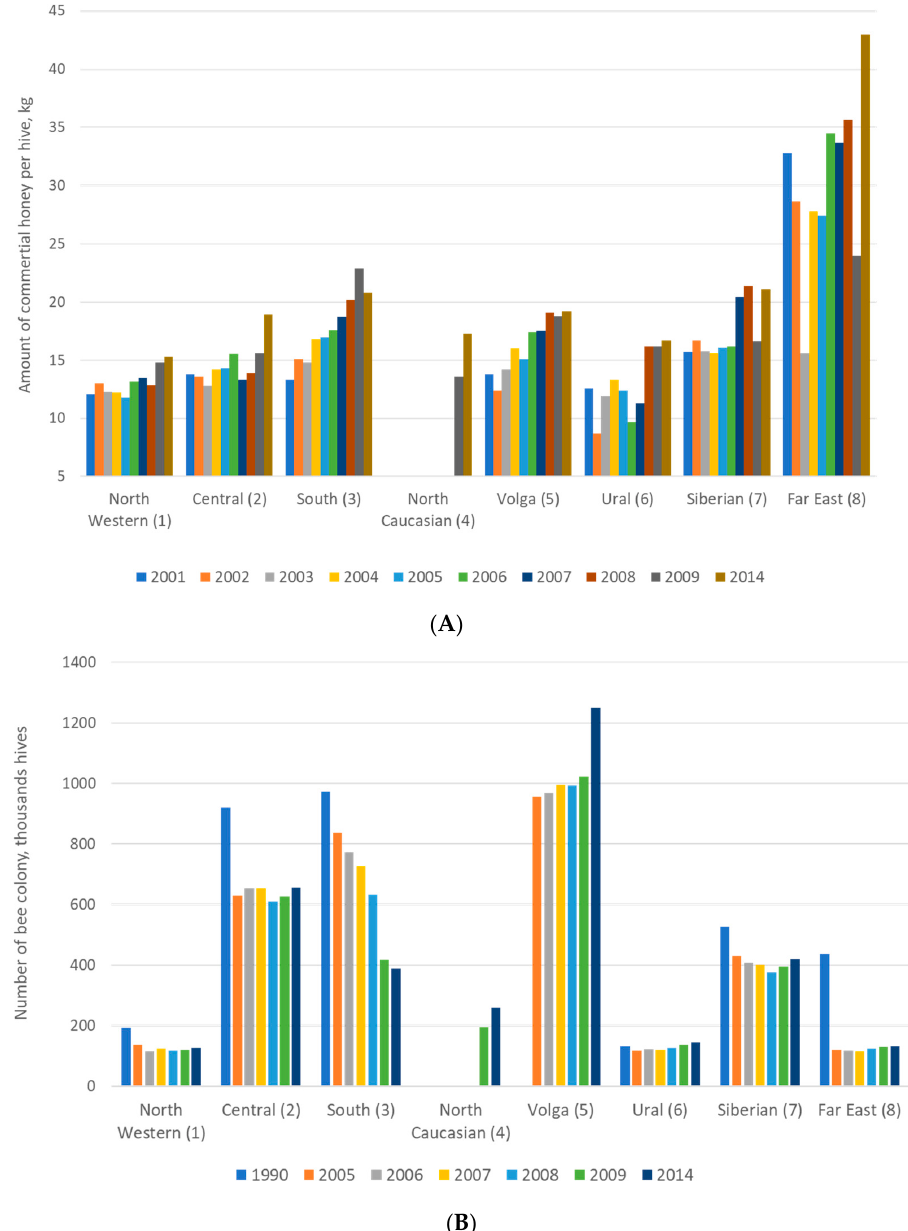
Figure 3. Honey productivity ( A ) and number of bee colonies ( B ) in eight federal districts in the Russian Federation. The morphometric method was developed by a Russian scientist, Alpatov (1929) [97] Morphometry is a quantitative phenotypic method that analyzes the size of morphologi- cal traits at the individual level in honey bees [98]. Ruttner (1988) [99] evaluated bees using thirty-three morphometrics traits, although Russian scientists preferred to measure no more than eight morphometric traits in honey bees: body color, length of the proboscis, width of tergite 3, length of veins “a” and “b” of the right forewing to calculate the cubital index, width and length of the metatarsus to calculate the tarsal index, and the discoidal shift of the right forewing [42,84,100]. The morphometric traits of local and new breed types of A. mellifera L. honey bees were analyzed for worker bees, queens and drones. However, the number of traits to be measured has not been strictly defined by scientists. Morphometric methods have nevertheless been used to distinguish between subspecies and hybrid forms of A. mellifera L. [1,85,101,102]. These morphometric traits were chosen for several reasons based on the long-term study of bees [36]. The length of the proboscis was the first trait measured to differentiate between honey bees [97]. The long proboscis was usually used to define the ability of honey bees to collect nectar from deep flowers. Later, traits from different parts of the body were used to characterize honey bees: tarsal index, cubital index, length of tergite 3 and the length and width of the forewing [100]. Furthermore, these traits have been used to differentiate the subspecies A. m. mellifera, A. m. carnica , and A. m. caucasia [6,102]. Although the measurement of morphometric traits has been used to separate the subspecies of honey bees, it was not capable of distinguish- ing between breeds of honey bees [103]. For this reason, the variability of a traits was compared. To accomplish this, the absolute value of the coefficient of variation and the standard deviation were calculated [6,84,103 – 106]. It was also reported that the length and width of the forewing and body characteristics were associated with honey production [78,107 – 109]. Two morphometric traits (the length of the proboscis and length of tergite 3) and two indices (cubital and tarsal) of worker bees are presented in Table 1 and used be- low by us (Figure 4).